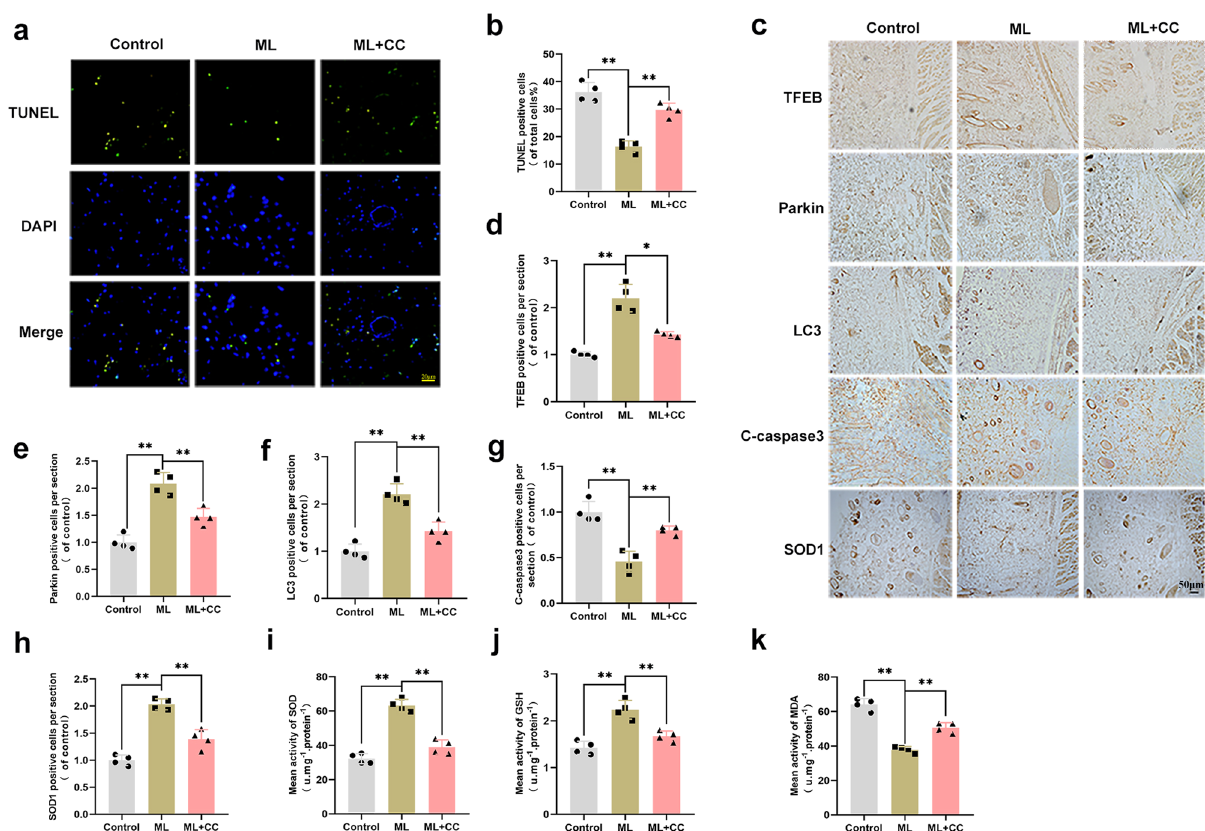
Fig. 8 In vivo, ML reduced apoptosis and oxidative stress via inducing mitophagy. a , b . TUNEL staining was performed to detect apoptosis in the fl ap in control, ML, and ML + CC groups (bar: 50 μ m). c – h IHC results exhibited the expression of TFEB, Parkin, LC3, C-caspase3, and SOD1 positive cells in each group and the optical density values of these proteins were quanti fi ed (bar: 50 μ m). i Total SOD activity was detected by xanthine oxidase method. j GSH level was assessed by modi fi ed 5,5 ′ -dithiobis method. k MDA level by measured by thiobarbituric acid test. All experiments have been performed at least 4